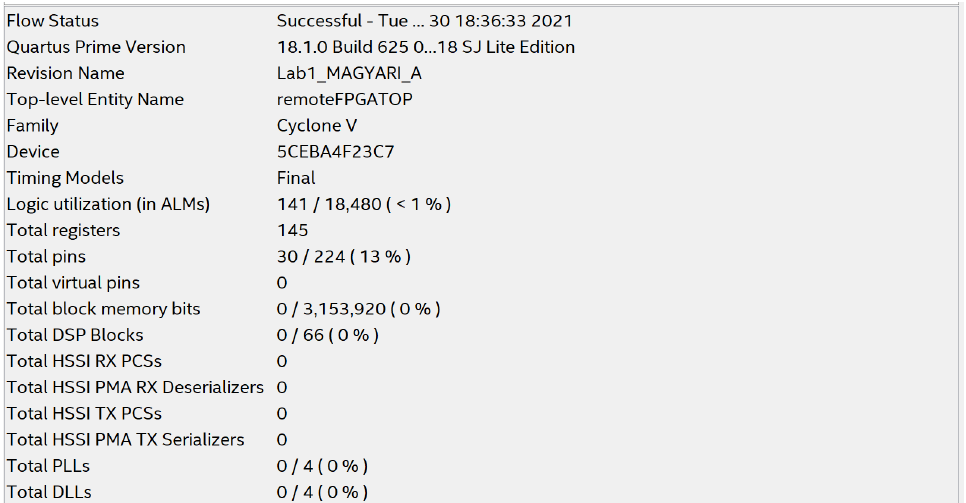
Figure 9. The synthesis report of the FPGA hardware wrapper for remote operation on a DE0-CV development board.